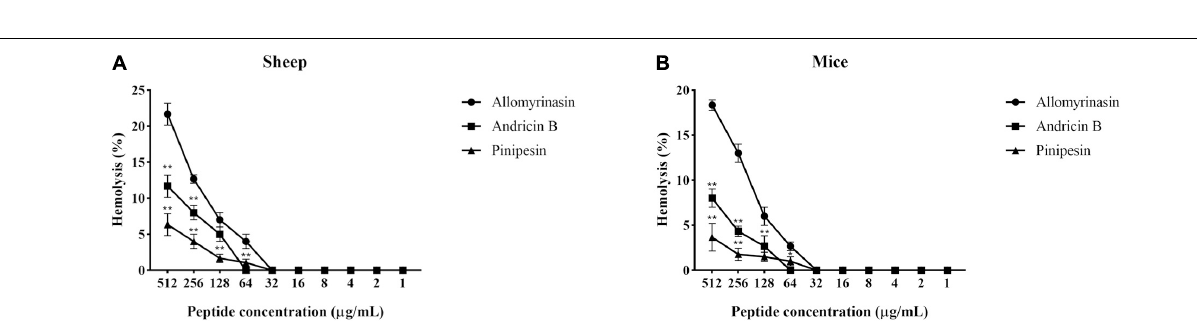
Frontiers in Microbiology |